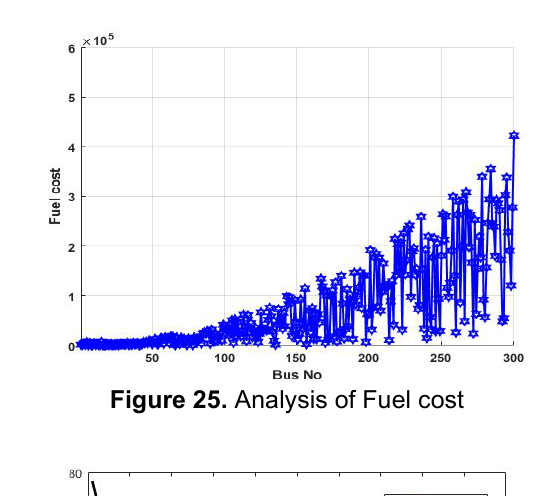
Figure 24. Analysis of fitness function